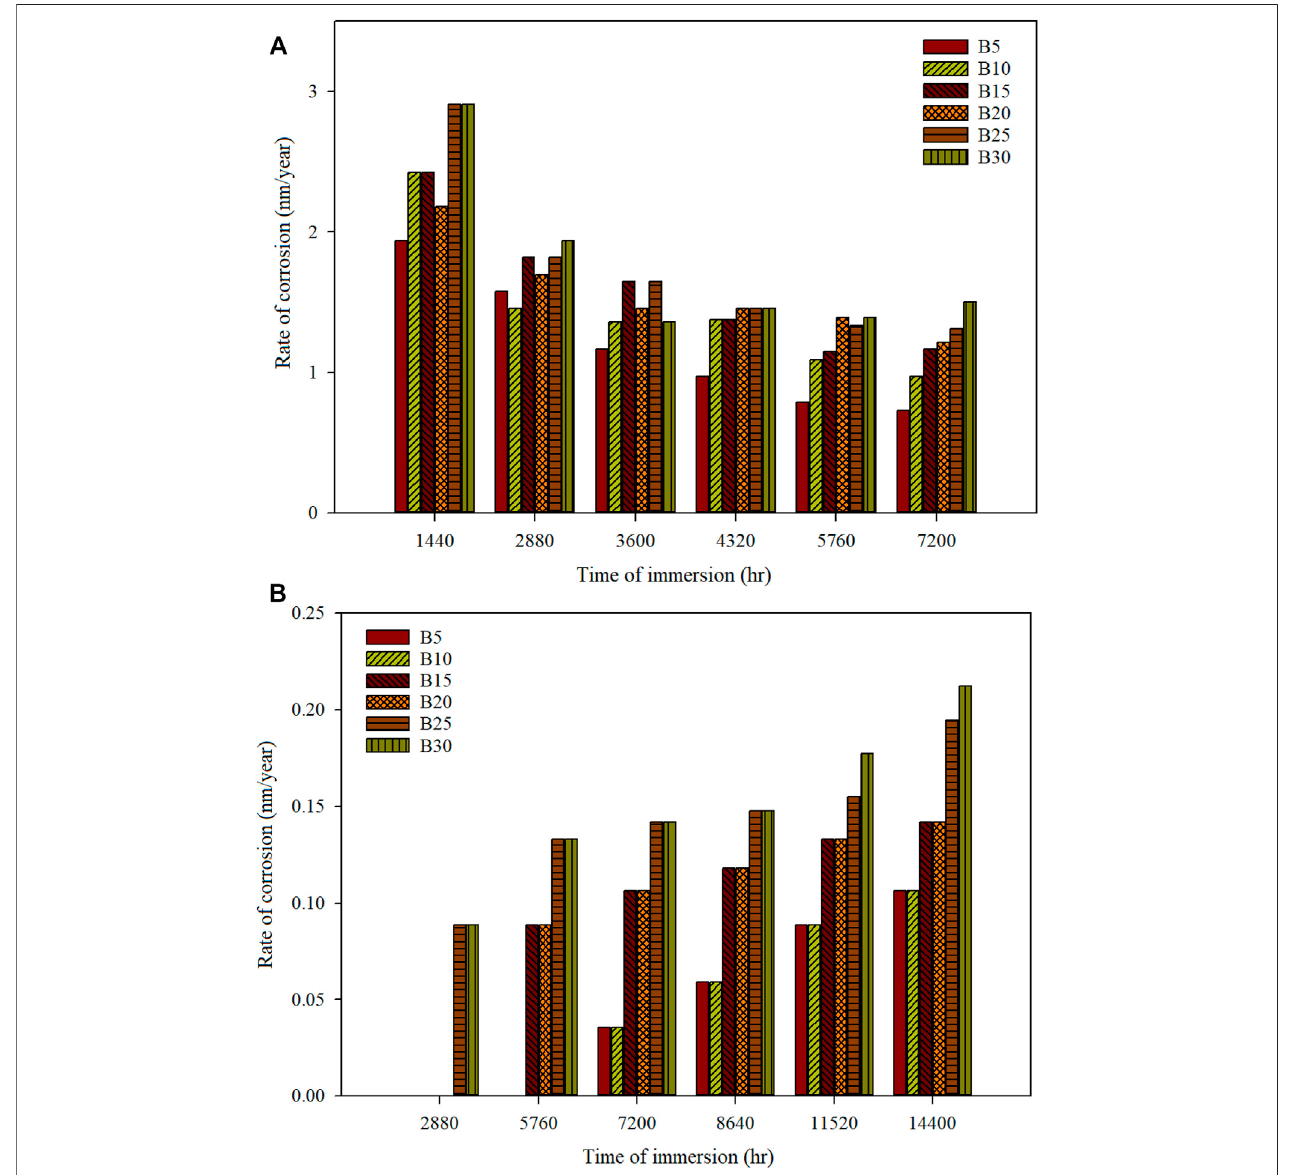
FIGURE 1 | Rate of corrosion of different biodiesel-diesel blending ratios for (A) mild steel and (B) stainless steel 316 for a speci fi c time of immersion.